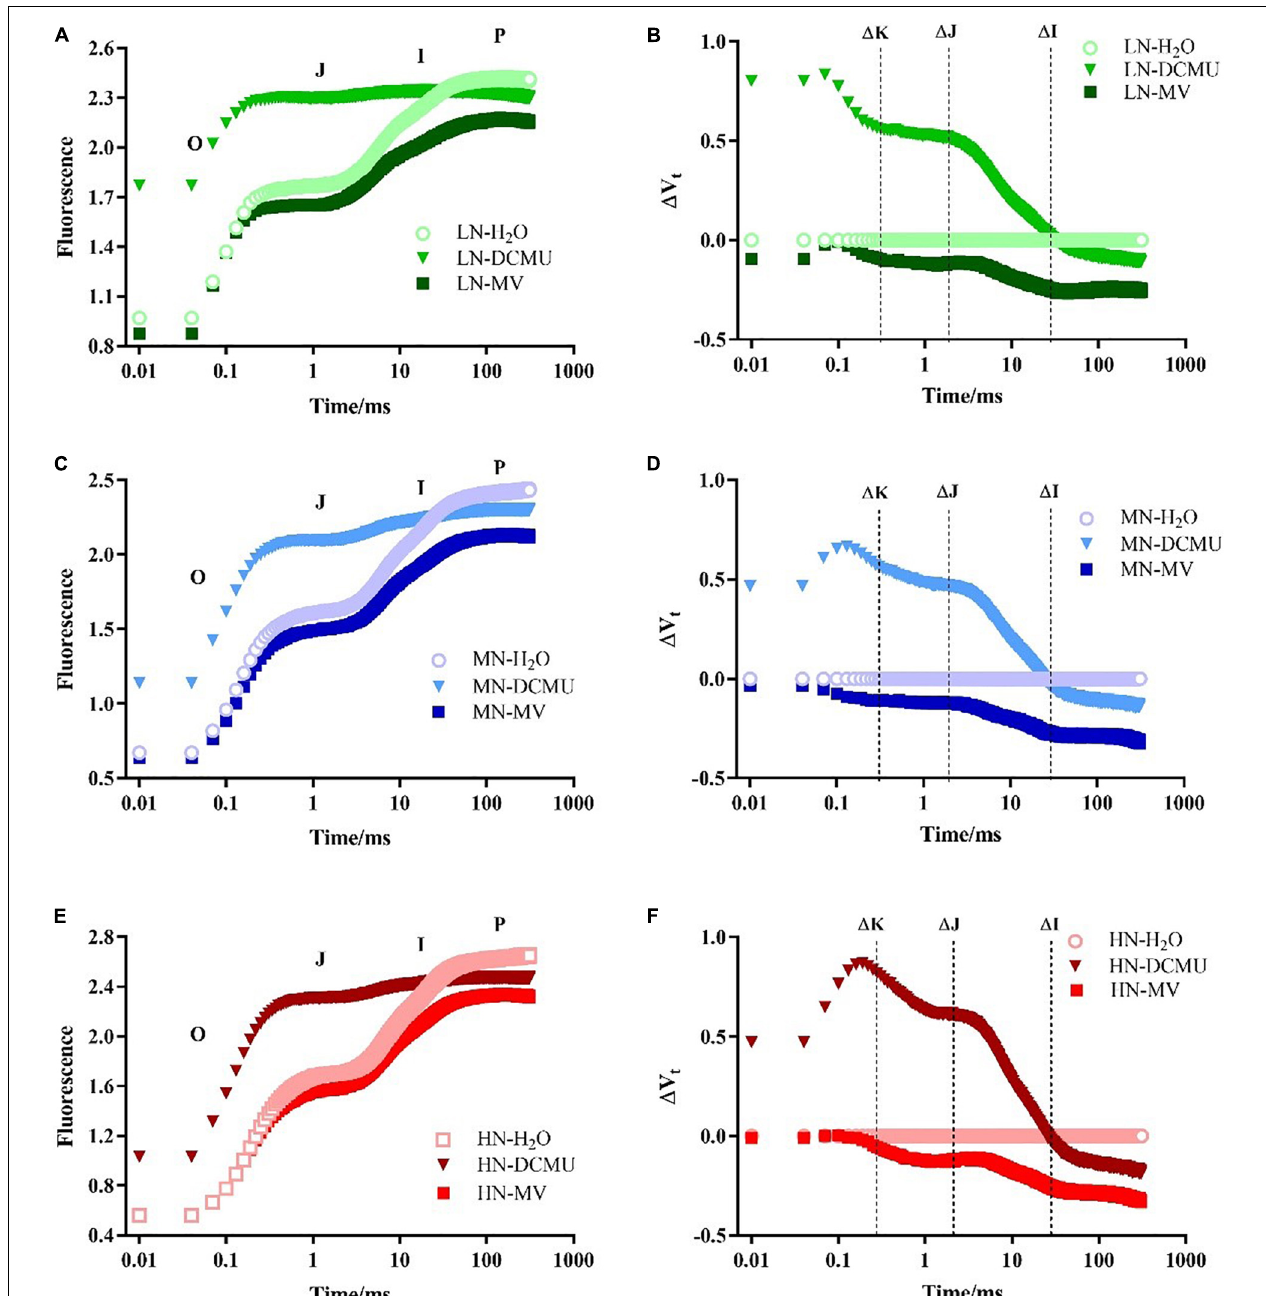
FIGURE 5 | Effects of 3-(3,4-dichlorophenyl)-1,1-dimethyl urea (DCMU) and methyl viologen (MV) on chlorophyll fluorescence transients in leaves of Panax notoginseng grown under different nitrogen (N) regimes. After infiltration with chemical reagents (H 2 O, DCMU, and MV) in darkness for 12 h. OJIP kinetic curves were measured as described in the section “Materials and Methods.” Panels (A,C,E) represent the N levels of LN, MN, and HN, respectively. O, J, I, and P phases represent the fluorescence at T = 20 µ s, 2, 30, and 300 ms, respectively. Effect of N levels LN (B) , MN (D), and HN (F) on relative variable fluorescence ( (cid:49) V t ) of Panax notoginseng after infiltration with chemical reagents (H 2 O, DCMU, and MV) in darkness. (cid:49) V t = V(treatment) – V(control), V(treatment) is the fluorescence of P. notoginseng treated with DCMU or MV; V(control) is the fluorescence of P. notoginseng treated with H 2 O. (cid:49) K, (cid:49) J, and (cid:49) I represent the relative variable fluorescence at T = 300 µ s, 2, and 30 ms, respectively. Values for each point were means ( n = 5).